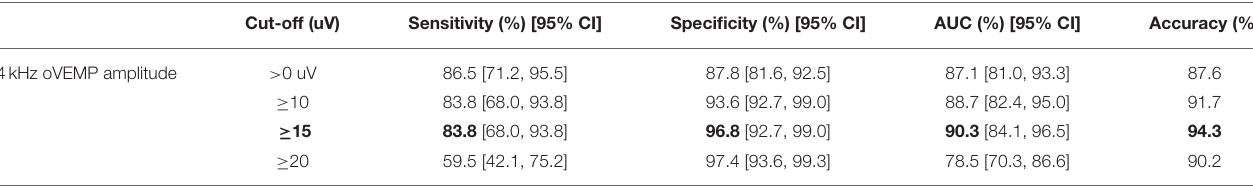
Sensitivity, specificity, area under the curve (AUC) and accuracy (i.e., percentage of cases correctly classified) are listed for each representative 4kHz oVEMP amplitude cut-off. AUC and accuracy are highest at the 4kHz oVEMP amplitude cut-off of 15 uV. Bolded row indicates the sensitivity, specificity, AUC, and accuracy of the optimal 4kHz oVEMP amplitude cut-off. AUC, area under the